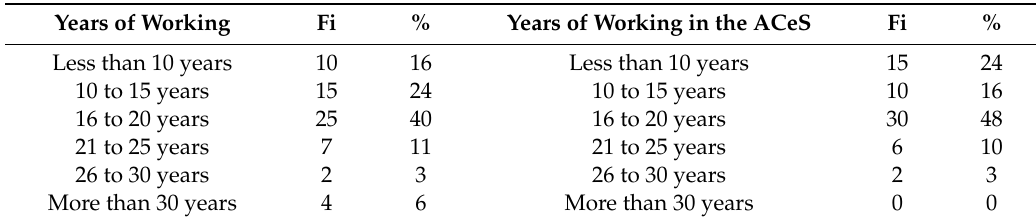
Table 4. Focus group participants profile concerning professional years of working and years of working in the ACeS.